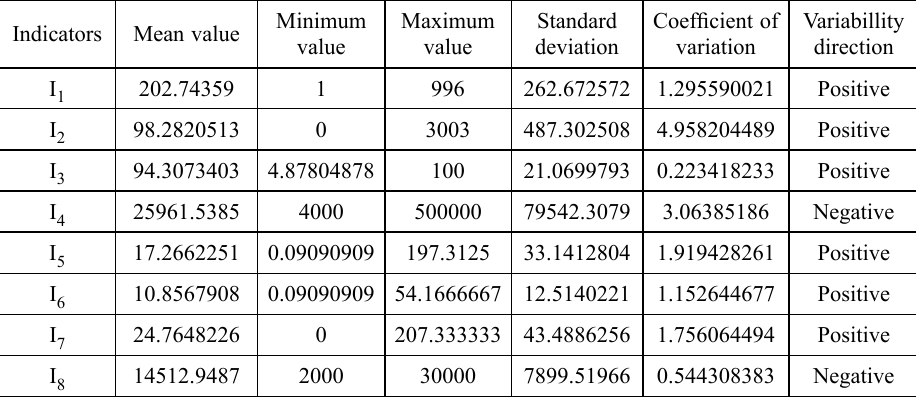
Table 3. Statistics summary of strategic